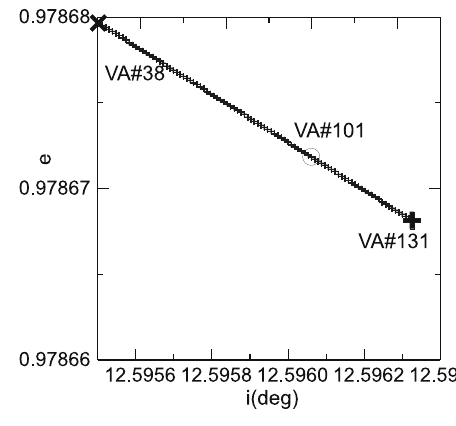
Figure 2: LOV of comet